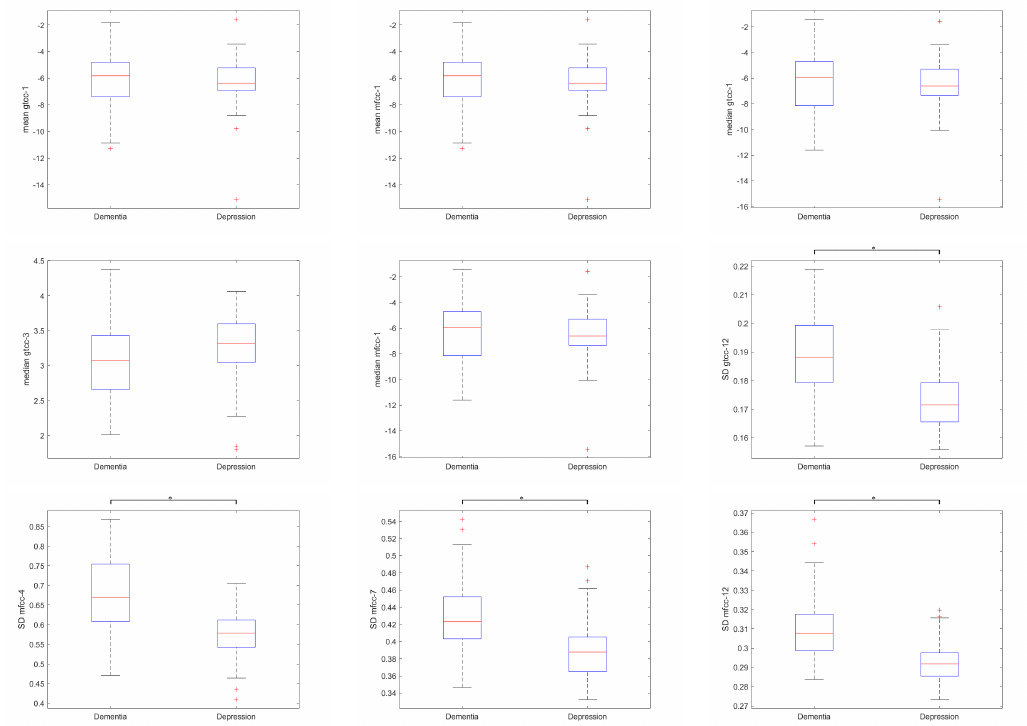
Figure 5. Distribution of features with significant correlation to HAMD and MMSE. * marks the statistically different features between the groups, corrected with Bonferroni